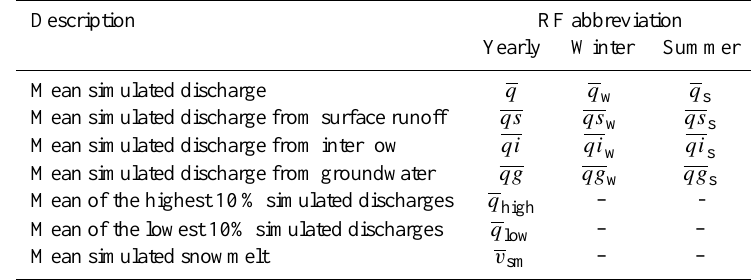
Table 1. Descriptions and abbreviations of the 15 response functions (RF) which were used in the sensitivity analysis.